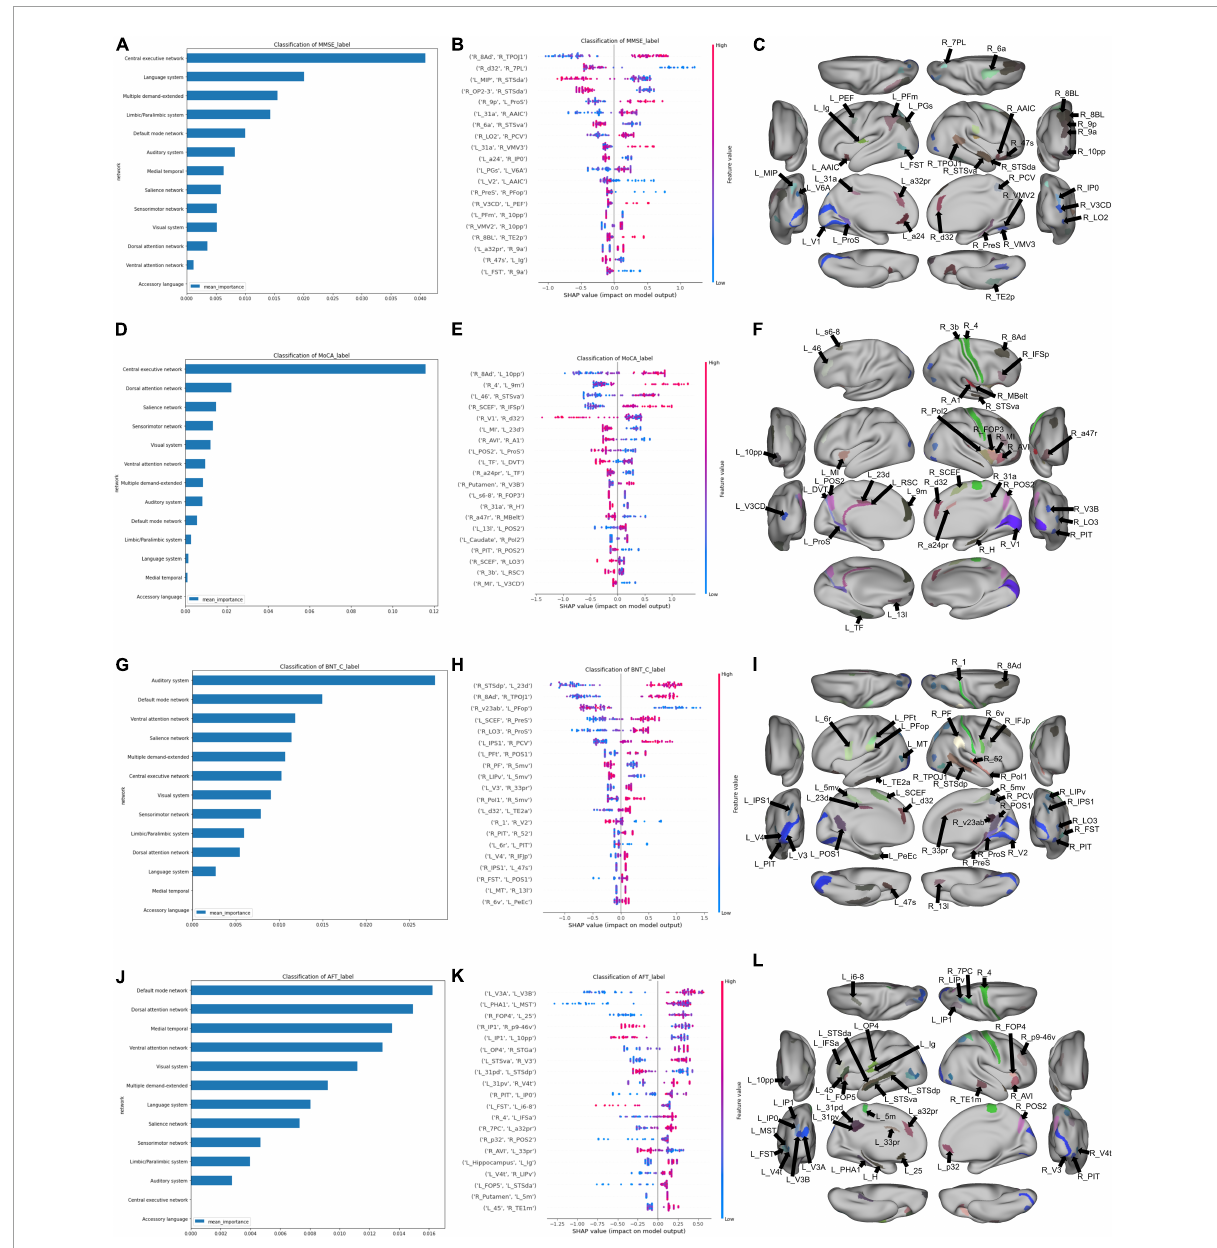
FIGURE3 Features associated with each machine learning model classifying subjects into neuropsychological performance. (A) A graph ranking network level features, and (B) a SHAP plot ranking the top 20 parcel-based features when classifying MMSE performance, along with, (C) an anatomical representation of the parcels comprising the top 20 features. (D) Network level graph, (E) SHAP plot, and (F) anatomical representation for the model classifying MoCA performance. (G) Network level graph, (H) SHAP plot, and (I) anatomical representation for the model classifying BNT performance. (J) Network level graph, (K) SHAP plot, and (L) anatomical representation for the model classifying AFT